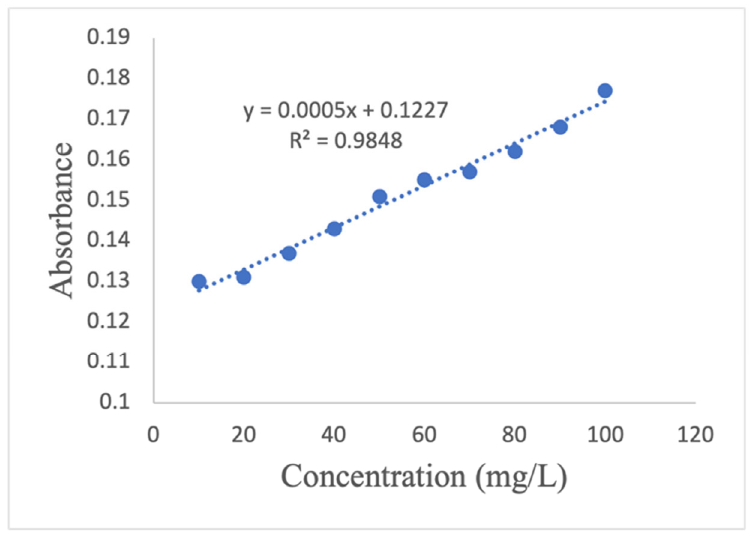
Fig. 7. Standard curve for arsenic.